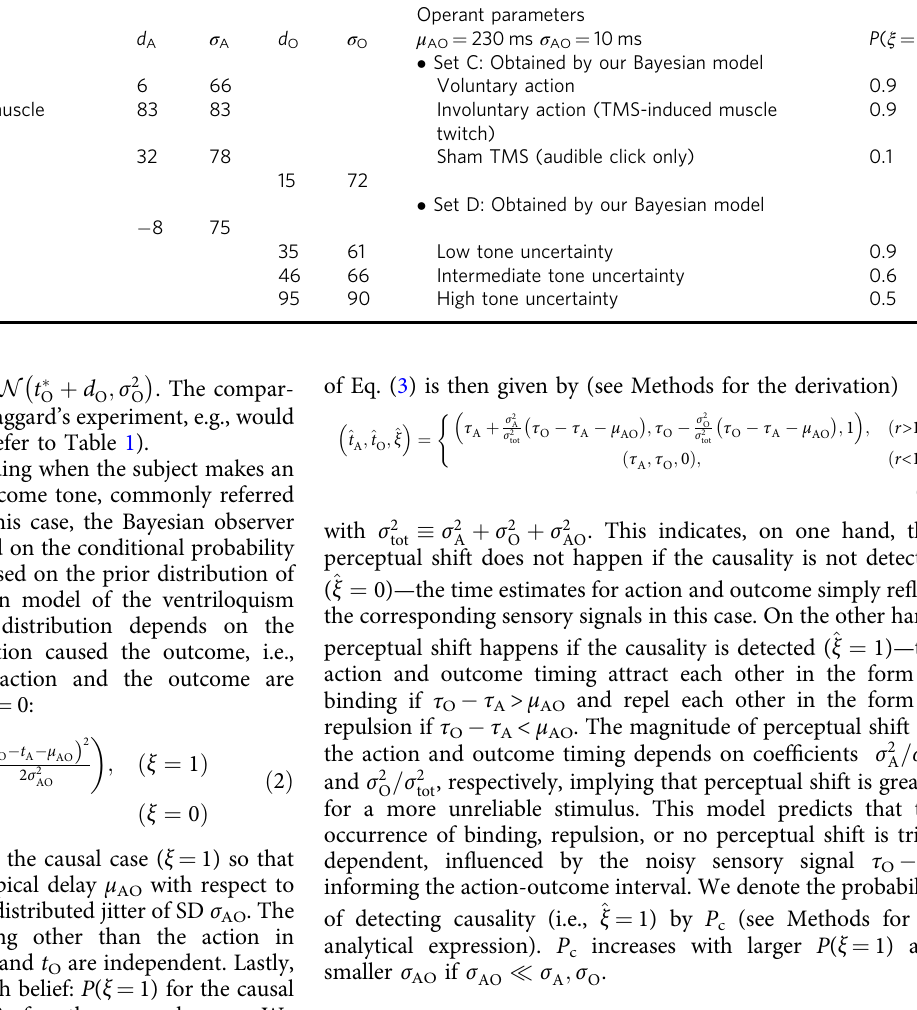
Table 1 List of Bayesian model parameters and their values Baseline parameters Operant parameters All are temporal values in unit